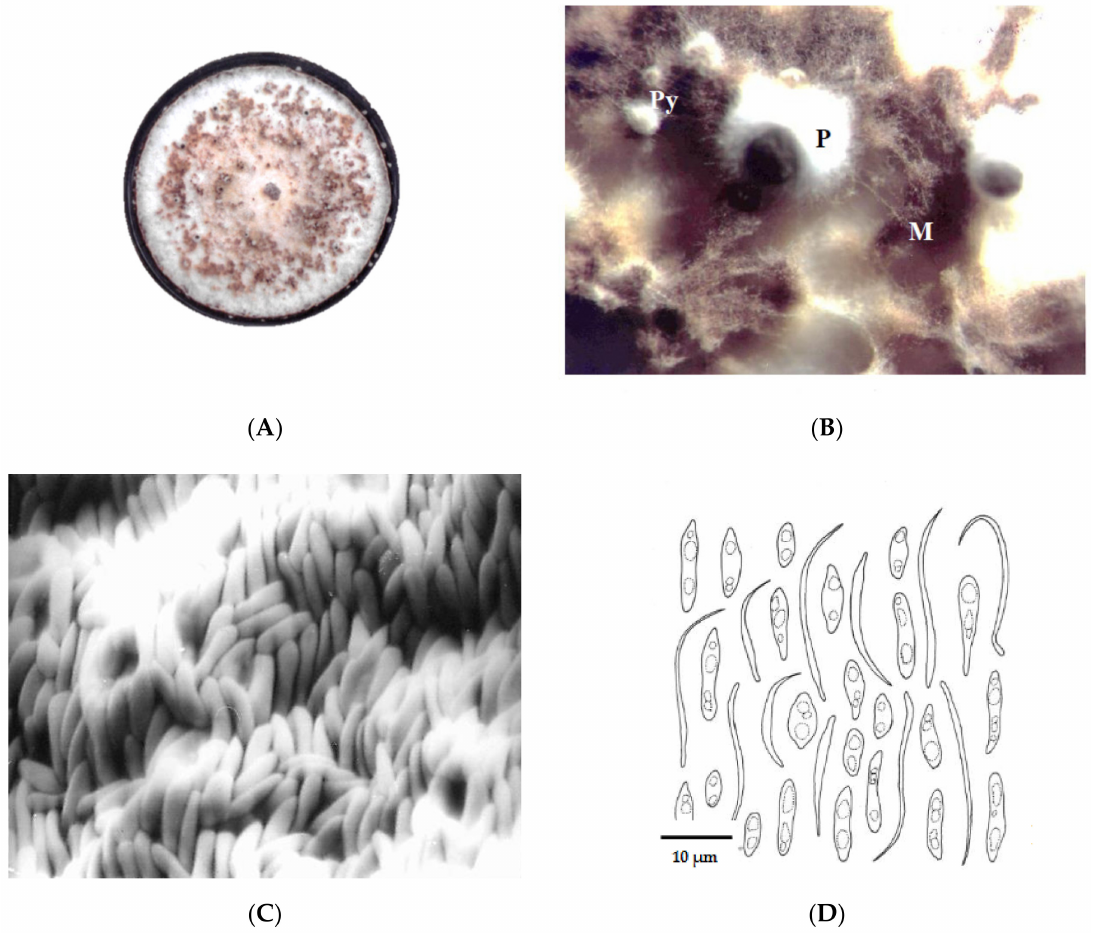
Figure 4. Phomopsis juglandina : ( A ) 21-days culture on malt agar; ( B ) P—mature pycnidia; Py—young pycnidia; M— mycelium; ( C ) Morphology (SEM) of alfa-conidia 2850x; ( D ) drawings of α and β conidia.